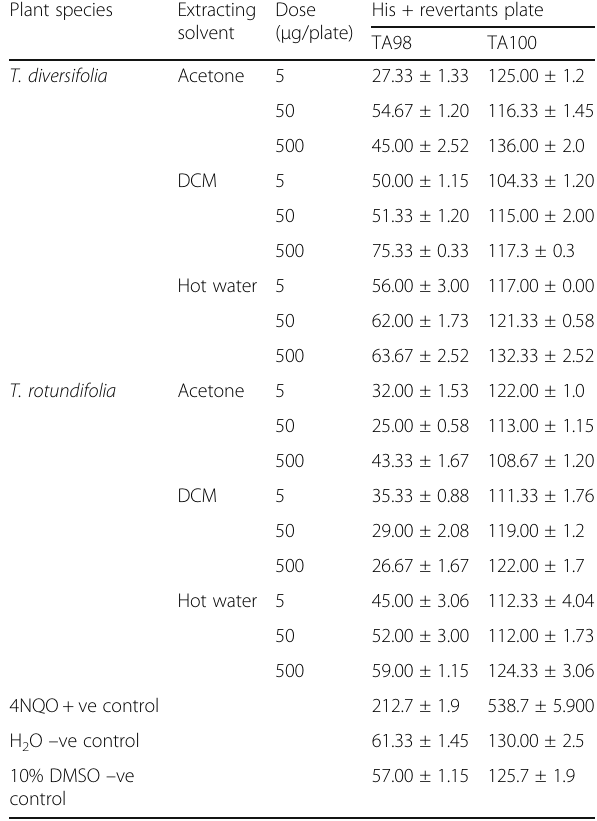
Table 8 Genotoxicity test of T . diversifolia and T . rotundifolia using Salmonella typhimurium strains TA98 and TA100 in the absence of exogenous metabolic activation Plant species